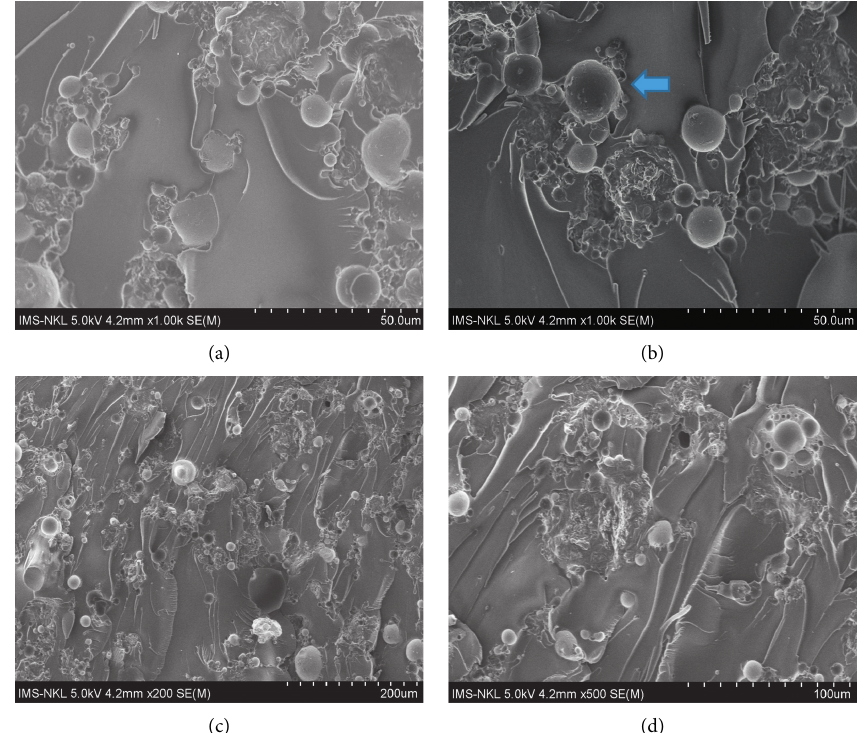
Figure 6: SEM image of the nanocomposite: (a) 20% fly ash, 3% nanoclay; (b) 30% fly ash, 3% nanoclay; (c) 40% fly ash, 3% nanoclay; and (d) 40% fly ash, 2% nanoclay.